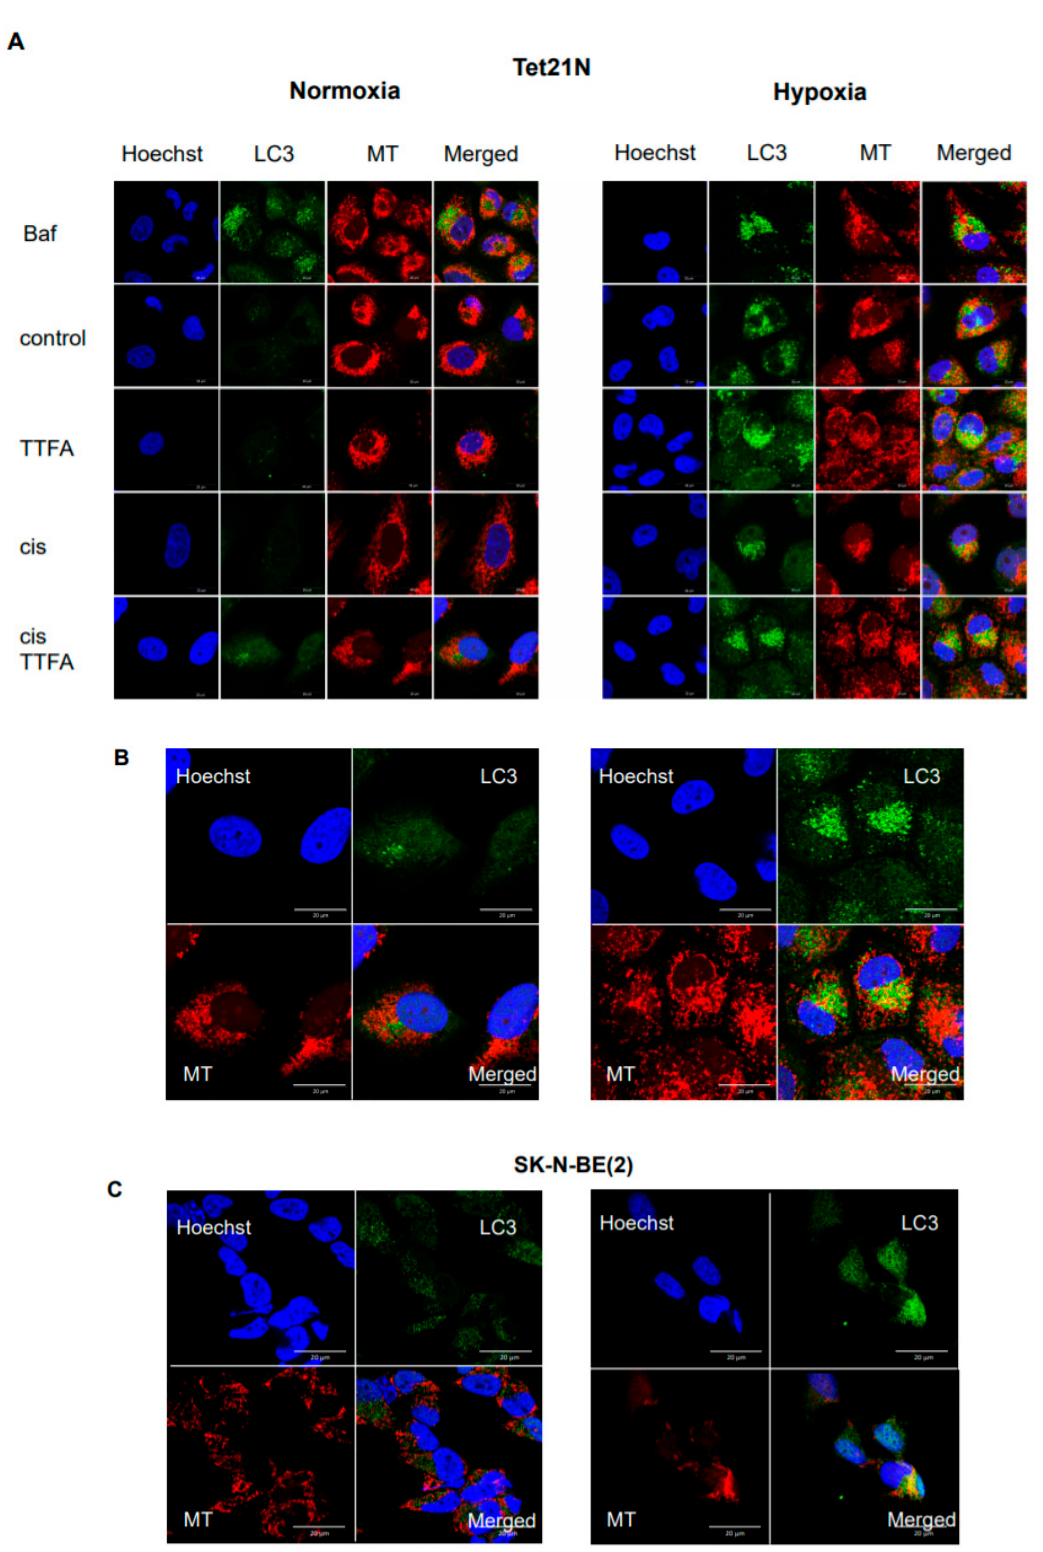
Figure 2. Hypoxia stimulates LC3 accumulation in Tet21N cells. Cells were stained with Hoechst (first column), antibodies against LC3II (second column), and mitochondrial dye Mitotracker CMXRos (third column). The fourth column represents merged images ( A ). Panels ( B , C ) represent high-magnification images of LC3 colocalization with mitochondria in Tet21N and SK-N-BE(2) cells treated with cisplatin and TTFA under normoxic and hypoxic conditions. Scale bar: 20 µ